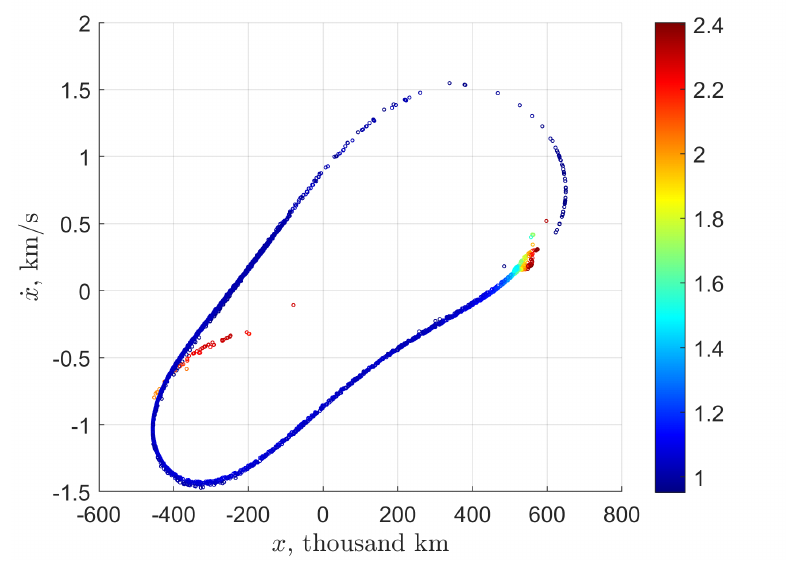
Figure 11. Earth–Moon RoP re-entry conditions corresponding to the exterior legs successfully patched with a departing leg. The color reflects the Jacobi integral value at